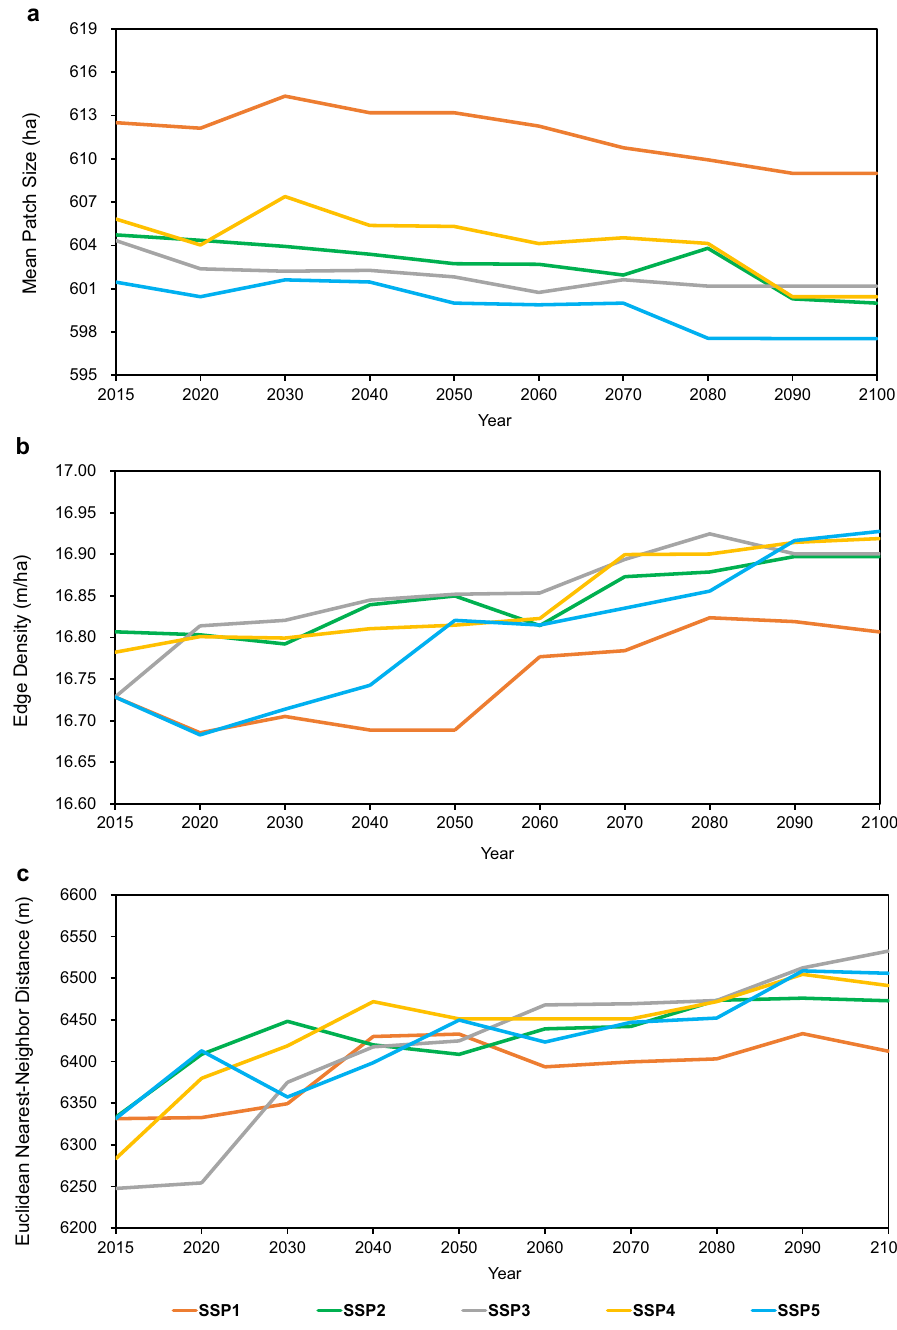
Fig. 3 Future urban expansion effects on habitat fragmentation under SSP scenarios. a Mean patch size (MPS), b edge density (ED), c mean Euclidean nearest-neighbor distance